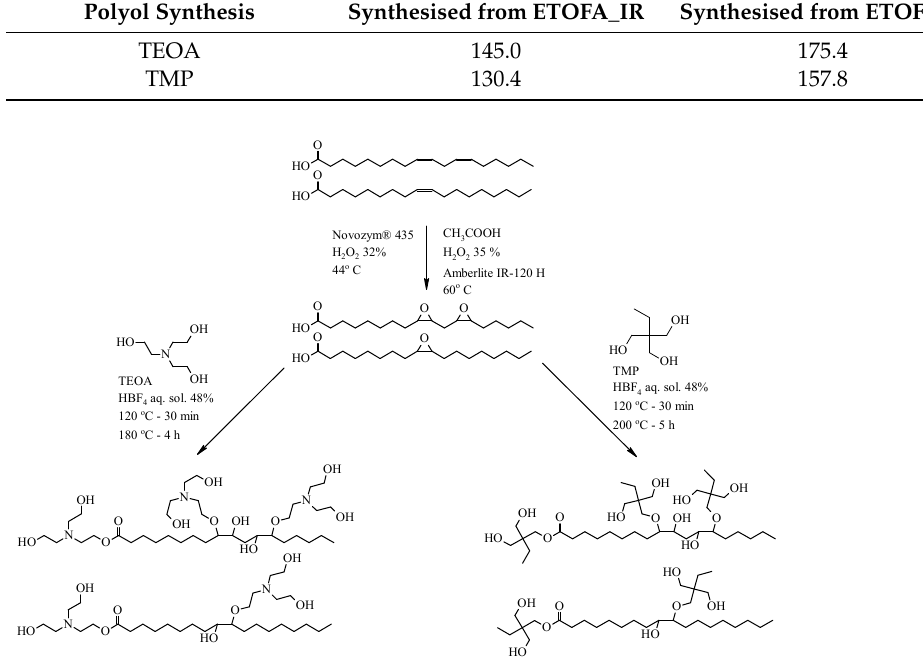
Table 1. Multifunctional alcohols/amines used in the bio-polyol syntheses. Multifunctional Alcohol for